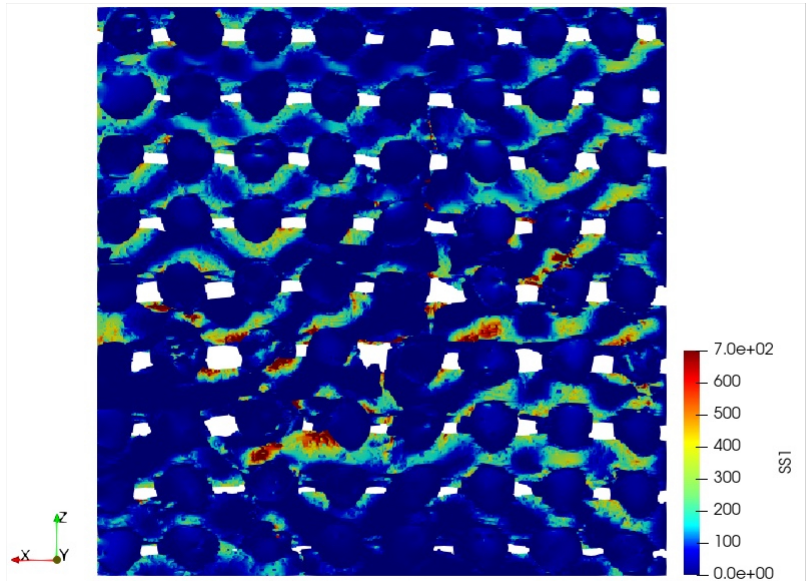
Figure 7. Color plot of stress component σ xx upon compression along